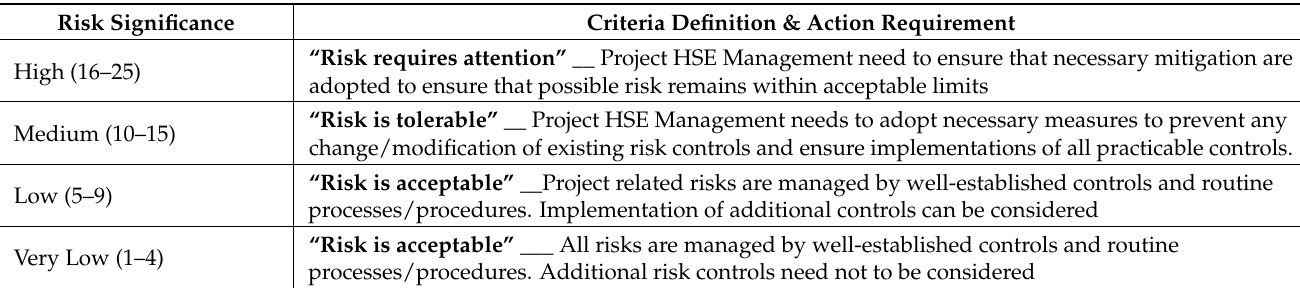
Table 4. Risk criteria and action